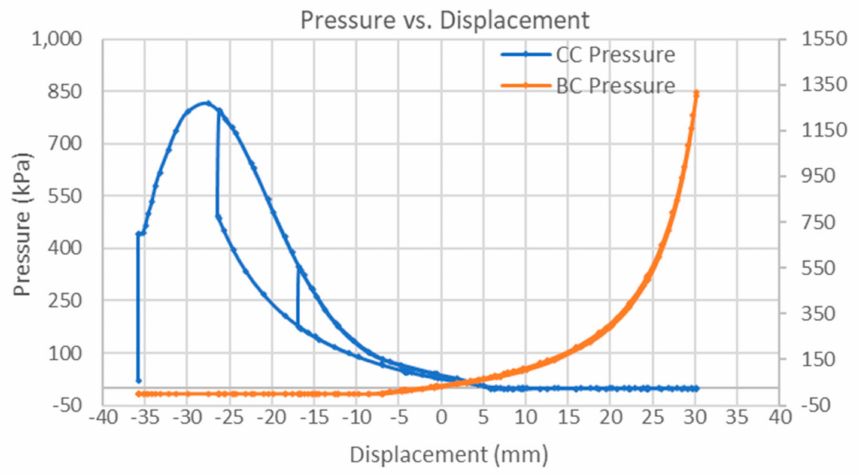
Figure 5. No-load operation: pressure vs. displacement profile for CF = 0.3. Increasing CF to 0.38 resulted in pressure profiles as shown in Figure 6. Endpoint displacement in CC was observed to be further inside, but the combustion was still not strong enough to achieve the required compression ratio for sustained operation. It also resulted in oscillating the piston assembly with shorter displacement each time, before the engine eventually stopped.